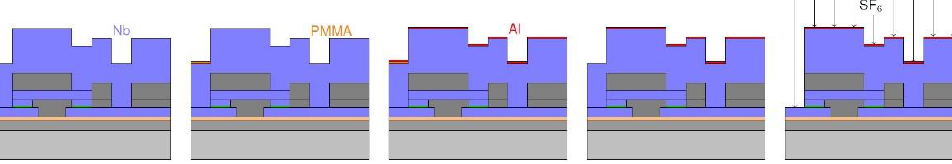
Figure 5. Layer scheme of the nanoSQUID fabrication process to define the second Nb wiring layer. After MSD of this third independent Nb layer the Al hard mask is patterned by a positive resist mask and a subsequent lift-off process and the second Nb wiring layer is etched with ICP RIE using SF 6 .